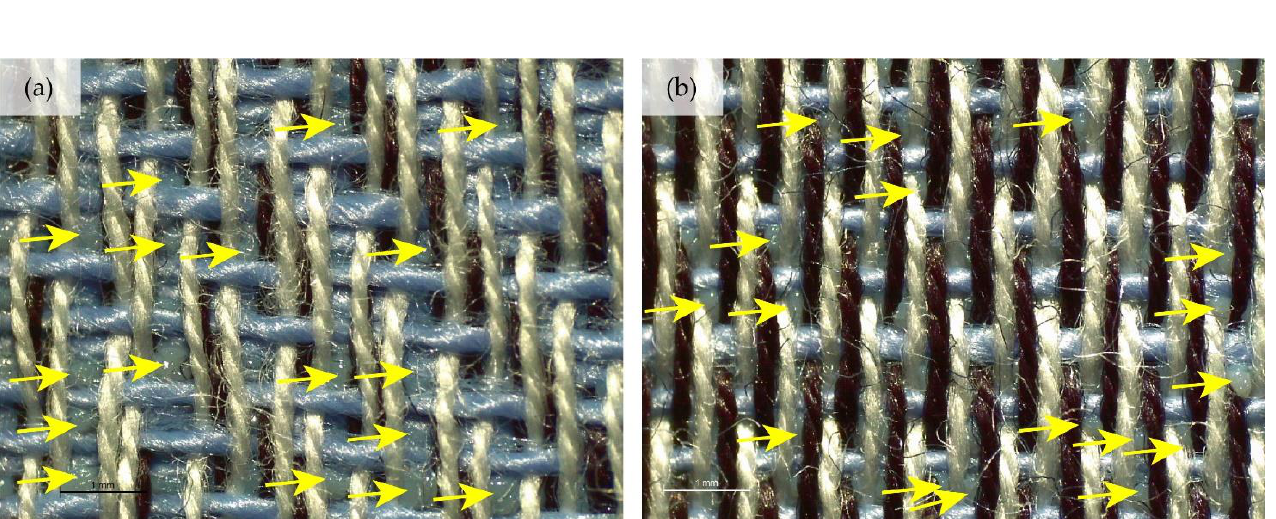
Figure 7. Images of the backs of printed fabric samples acquired with an optical microscope (mag. 20 × ) with marked deposits of molten polymer: ( a ) DT13Z 30, z = 0.25 mm; ( b ) T13Z 15, z = 0.25 mm.